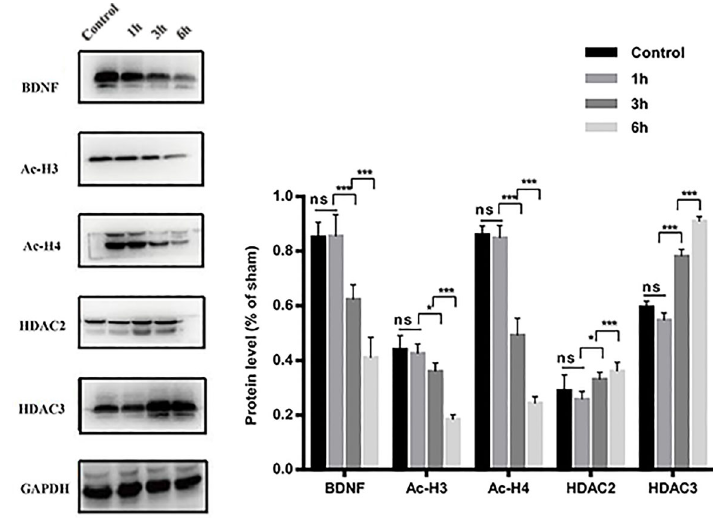
Figure 2. Effects of 2.5% sevo fl urane exposure during late pregnancy on postnatal day 1 offspring rats. Exposure to 2.5% sevo fl urane for 3 and 6 hours in late-pregnancy rats decreased Ac-H3, Ac-H4, BDNF, and increased HDAC2 and HDAC3 in the hippocampus. Compared with the 3-h group, the levels of Ac-H3, Ac-H4, and BDNF were reduced, and the levels of HDAC2 and HDAC3 were increased in the 6-h group. Data are reported as means ± SD. *P o 0.05, ***P o 0.001 (ANOVA followed by Tukey ’ s test). ns: not signi fi